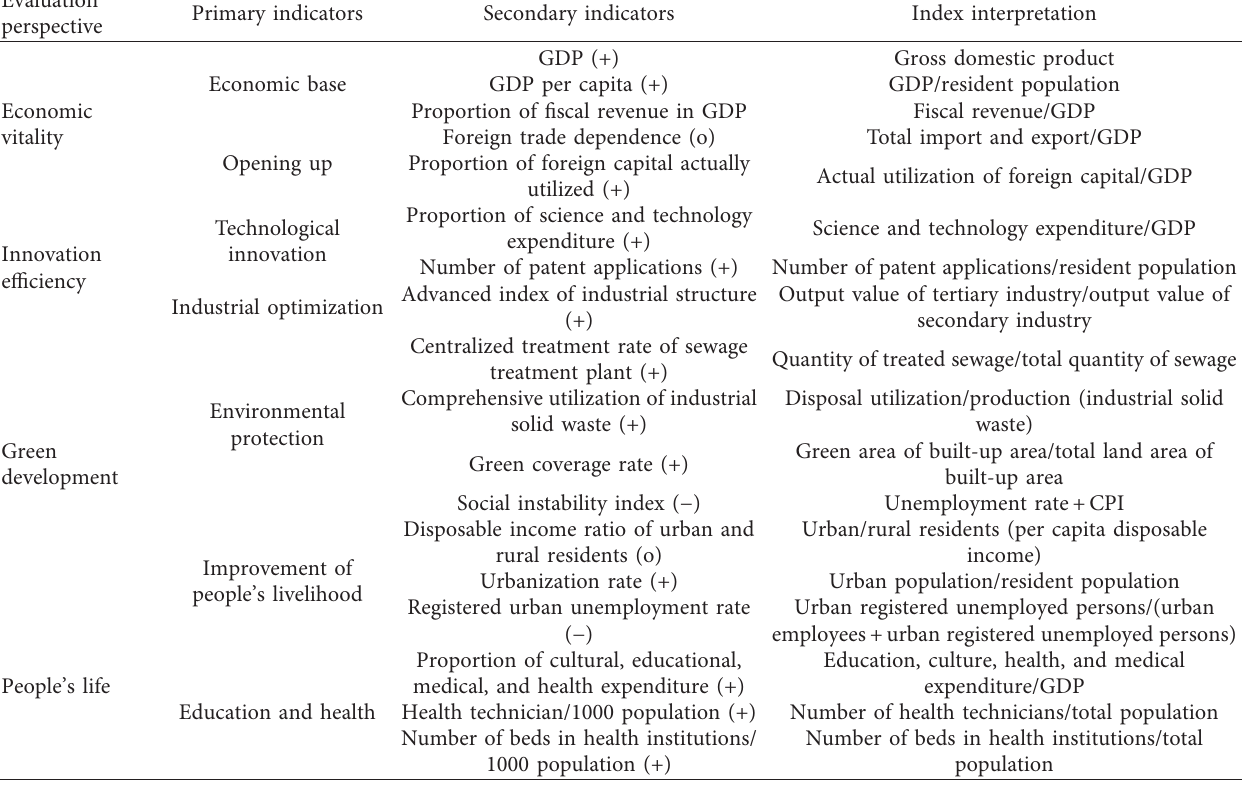
Table 1: Evaluation index system of urban competitiveness in Huaihe River eco-economic